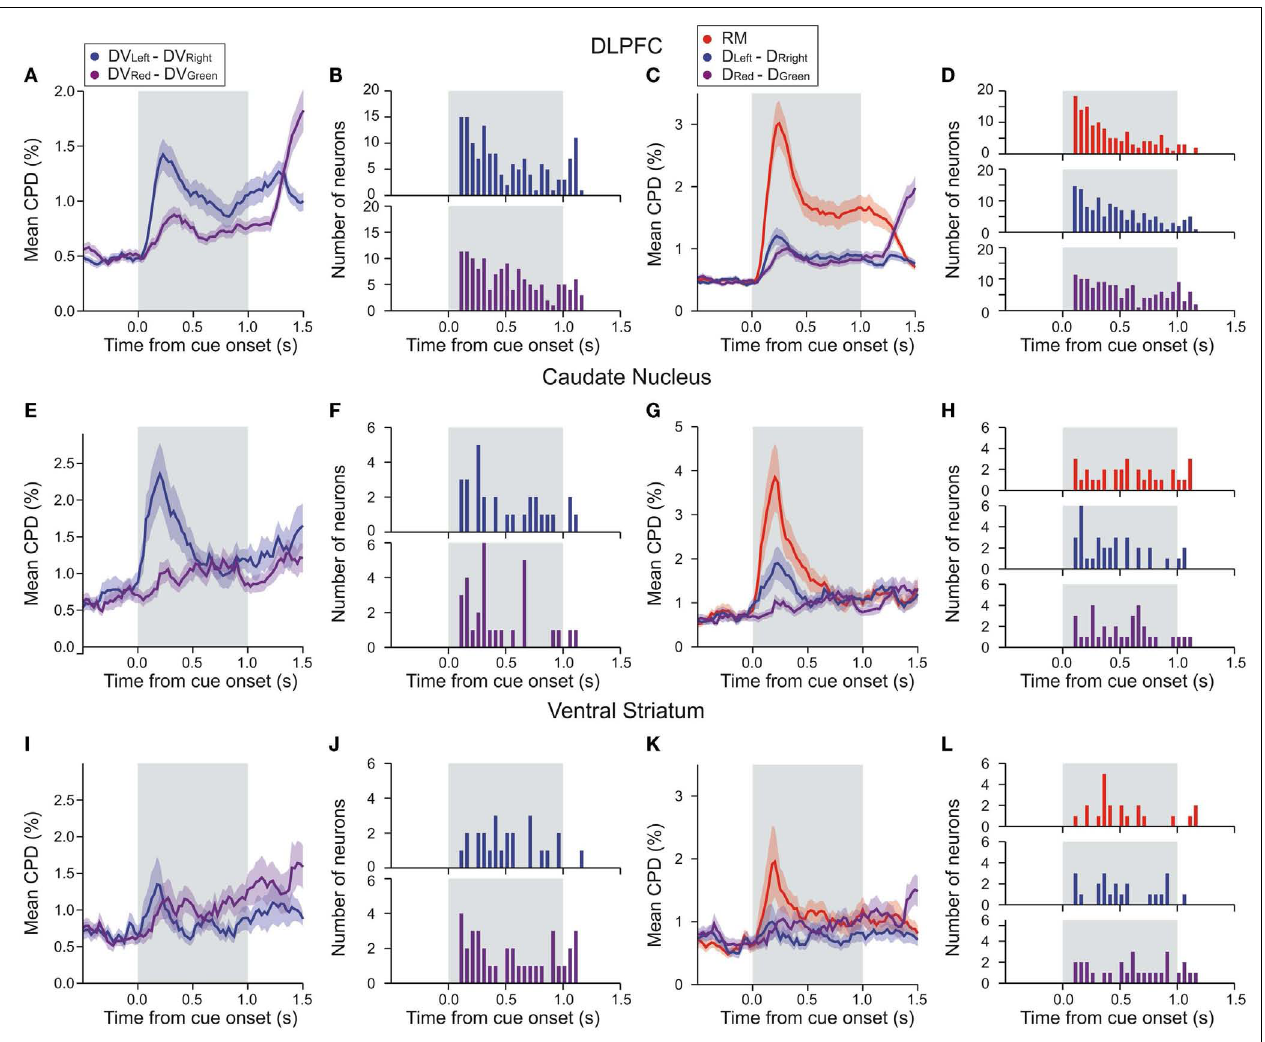
the difference in the DVs. In (C,G,K) , average CPD for the difference in the reward delays for the left and right targets (blue), the difference in the reward delays for the red and green targets (purple), and the position of the red (large reward) target (RM, red) are shown. Frequency histograms in (D,H,L) show the latency for the neural activity related to the difference in reward delays and the activity related to reward magnitude. Shaded areas,